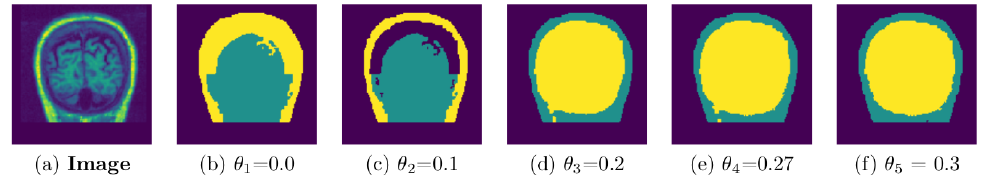
Figure 13. A representative coronal section from 3D MRI showing the separation of components for different thresholds: MRI from a single subject (IBSR data set) experimented using different thresholds and nodes sample size is 20,000. GUBS is run on 3D and for visualization we take 2D at the same location for all